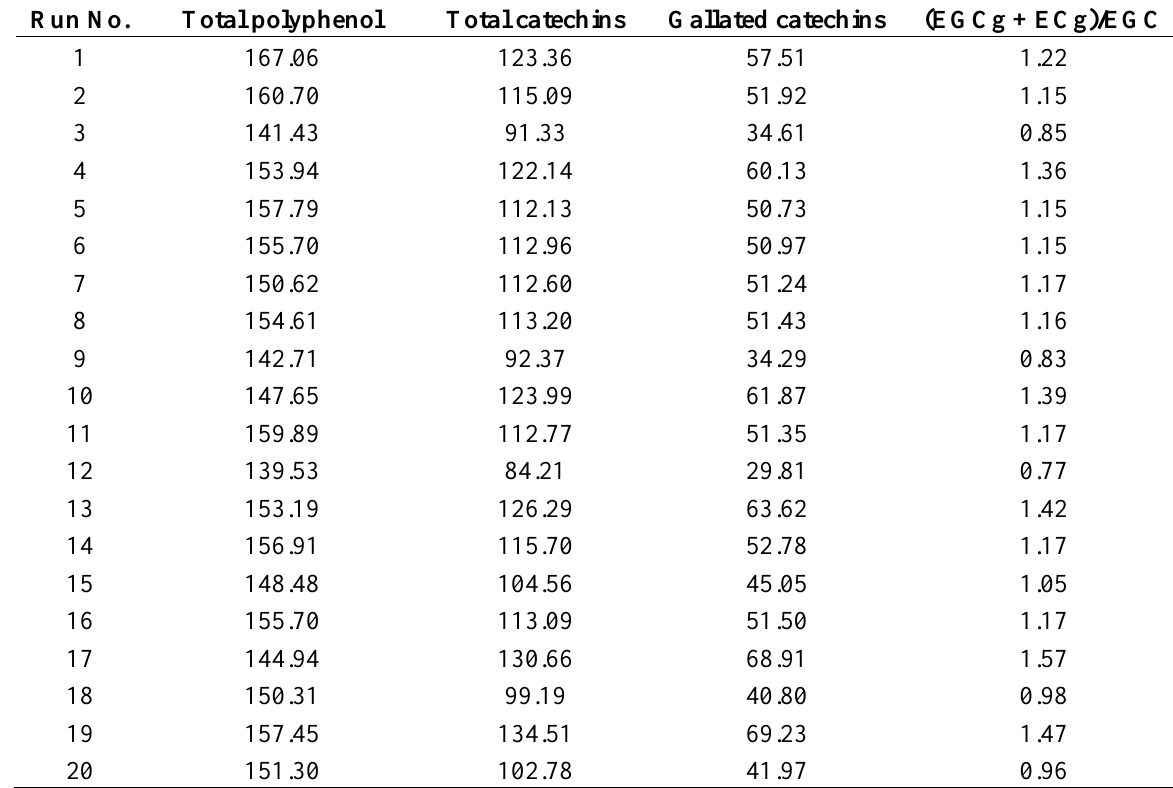
Table 5. Response values-related antioxidants obtained from experimental design. Run No.